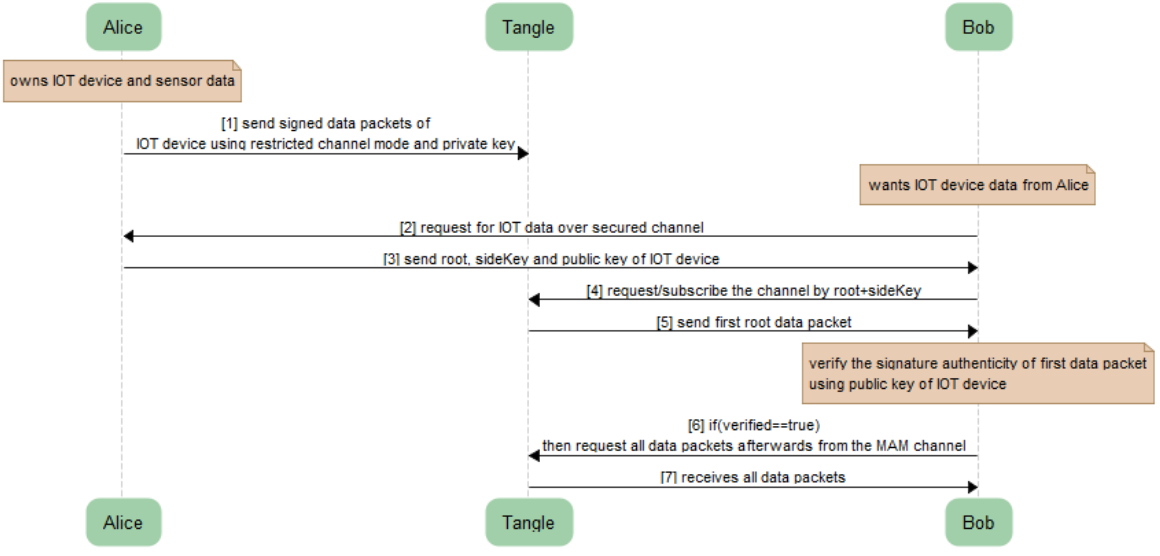
Figure 9. Sequence diagram for secured communication.